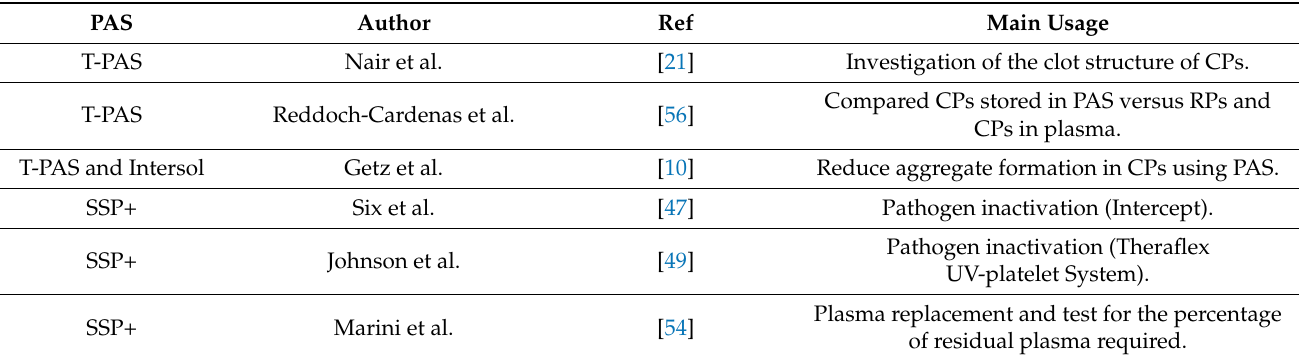
Table 1. Different platelet additive solutions (PAS) used in recent investigations of cold-stored platelets